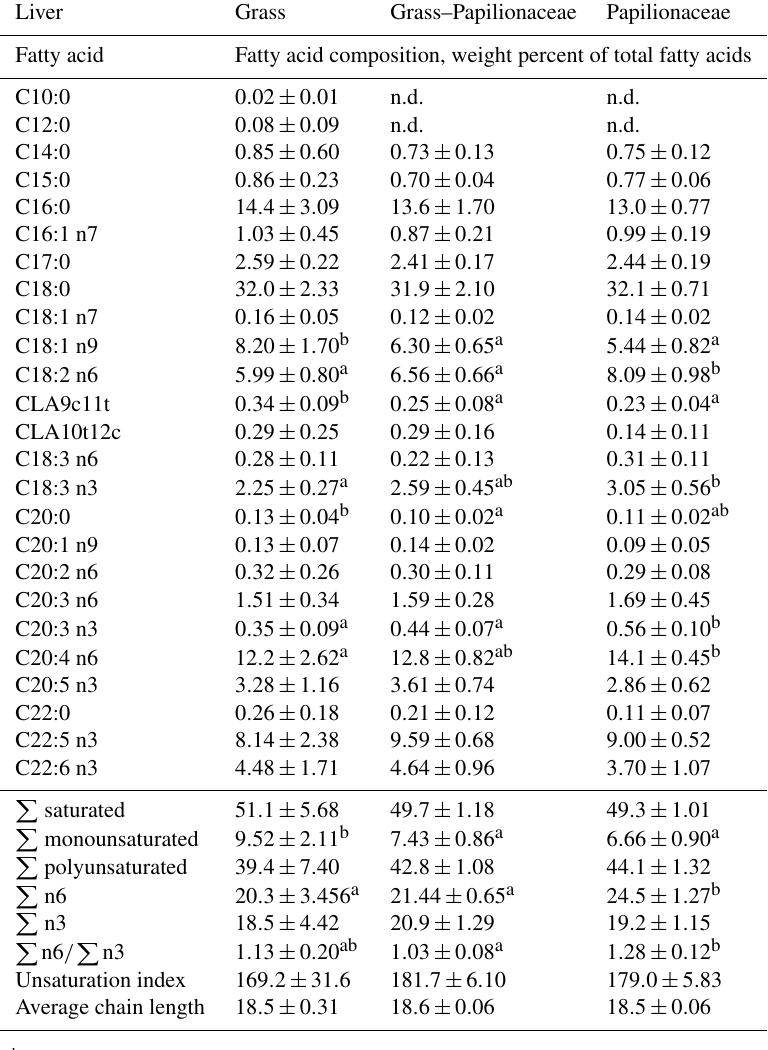
Table 6. Fatty acid composition of the liver of the three deer groups ( n = 10 per group, means ± SD). Liver Grass